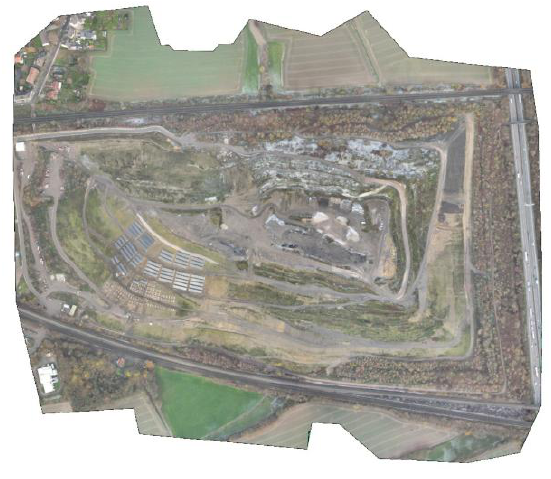
Figure 9 Orthomosaic of waste dump